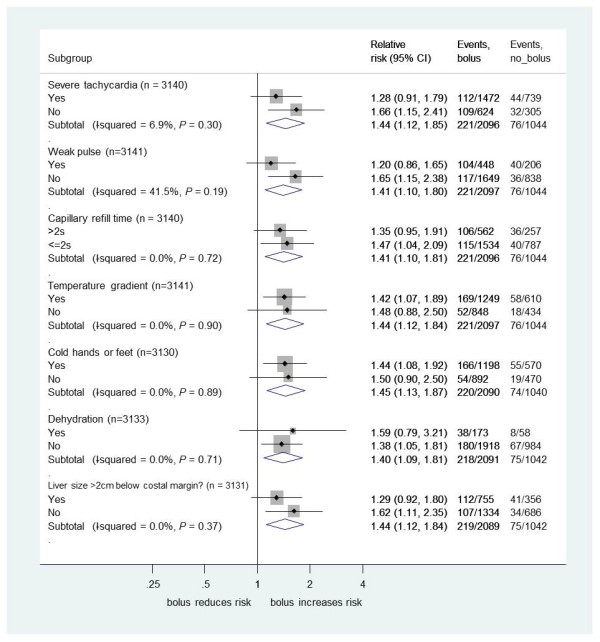
Mortality risk 48 hours for bolus compared to no bolus by shock-related or systemic signs at baseline.